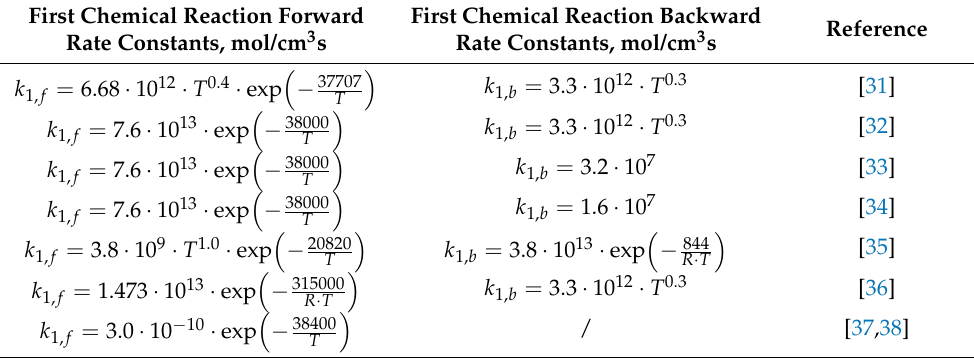
Table 2. Zeldovich mechanism first chemical reaction kinetic coefficient